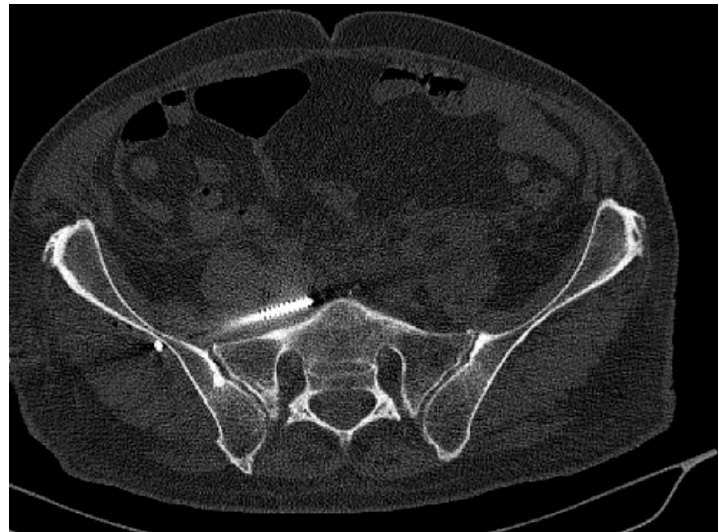
Figure 3. Screw anterior from S1—unrecognised sacral dysmorphism (Smith type-3 misplacement).